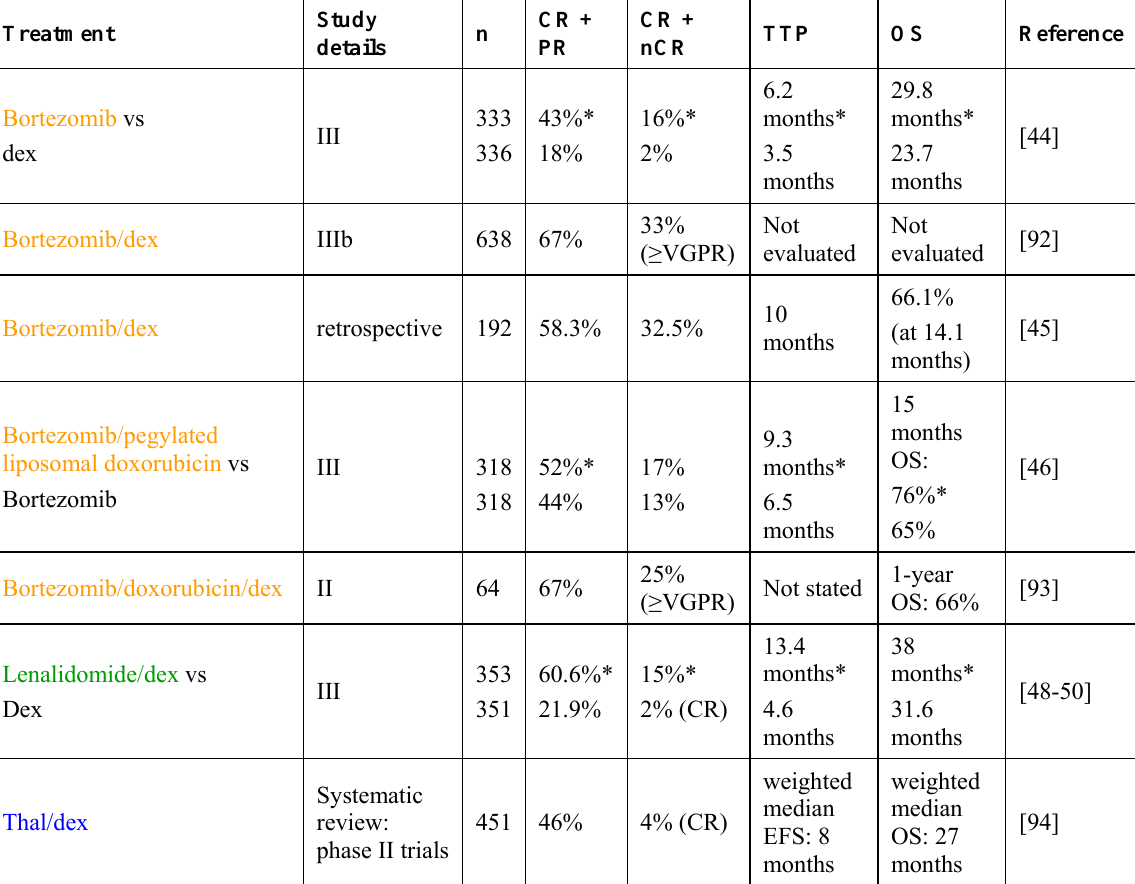
Summary of data for recommended regimens in relapsed/refractory setting.